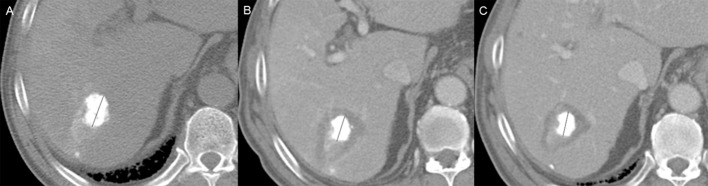
46 year-old man with hepatocellular carcinoma.(a) After transcatheter arterial chemoembolization (TACE), concentrated iodized oil delineates tumor on post-TACE CT (longitudinal tumor diameter, 27.8 mm). (b) Following completion of sequential radiofrequency (RF) ablation, low-attenuation ablation zone encircles index tumor. Tumor size diminished on post-ablation CT (decline in longitudinal tumor diameter: 27.8 mm → 20.7mm; 25.5% post-ablative reduction rate) for post-ablative volume reduction rate of 60.1%. (c) Stability of tumor confirmed by follow-up CT scan 1 month after RF ablation (20.7 mm → 20.4 mm).